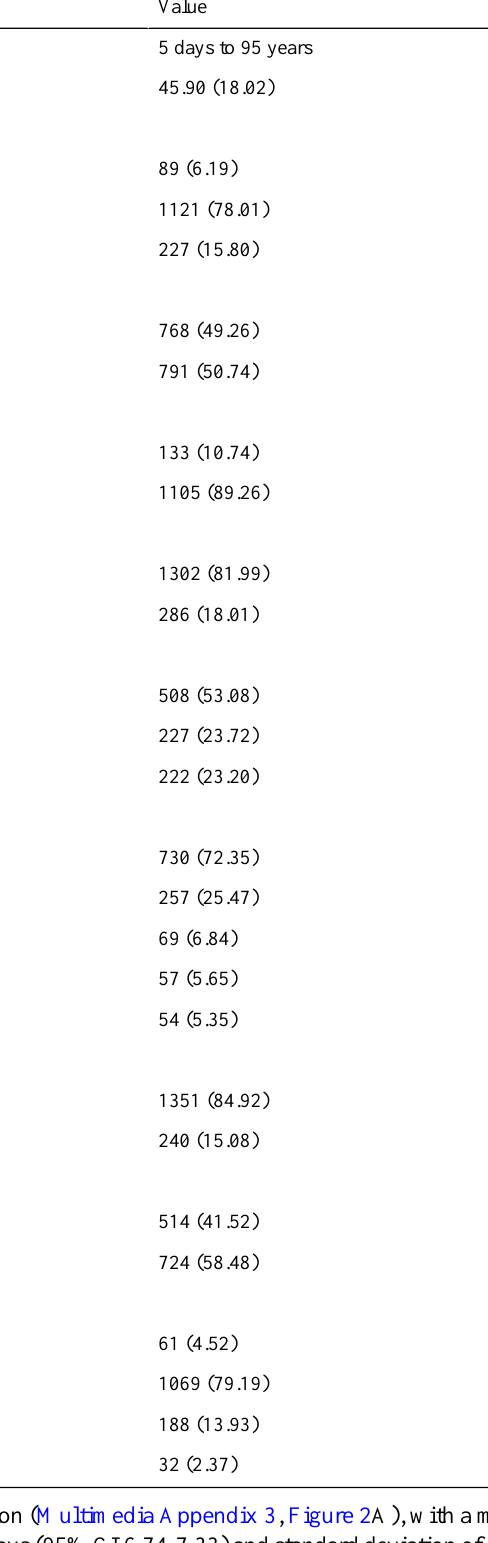
Table 1. Characteristics of included